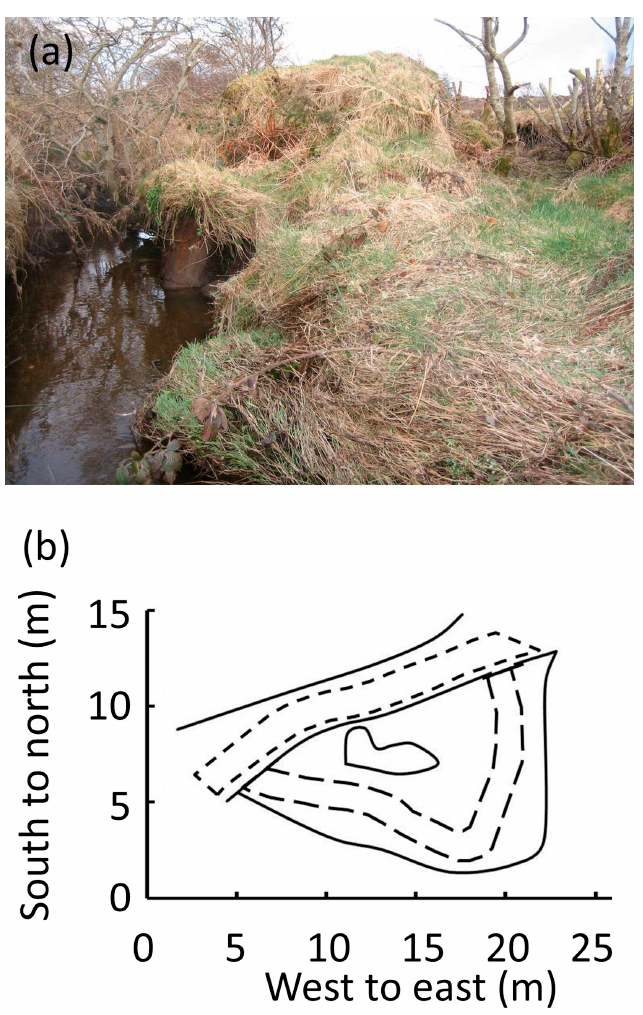
Figure A6. Fitzgerald’s “25 m long diversion of the stream” and the current path of the stream, which continues to the left and right of the contour map. ( a ) Photo of the site as seen from the western end; the channel made by the “globe of fire” is on the right and the stream that was recut by the Council is on the left. ( b ) Contour map of the site constructed from the survey and field notes. Solid lines: surface level. Long dashes: the bottom of the channel at -1.2 ± 0.25 m level. Short dashes: the bottom of the stream, as cut by the County Council in the 1980s, at the -1.9 ± 0.2 m level. Orientation to the north is approximate.